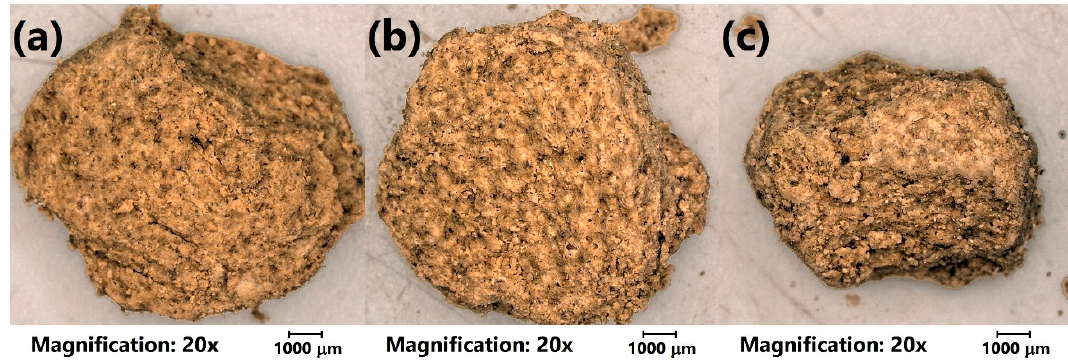
Figure 10. The appearance of the C 40 SS 40 sample’s surface after immersion in ( a ) NaCl, ( b ) NaOH, and ( c ) H 2 SO 4 solutions.